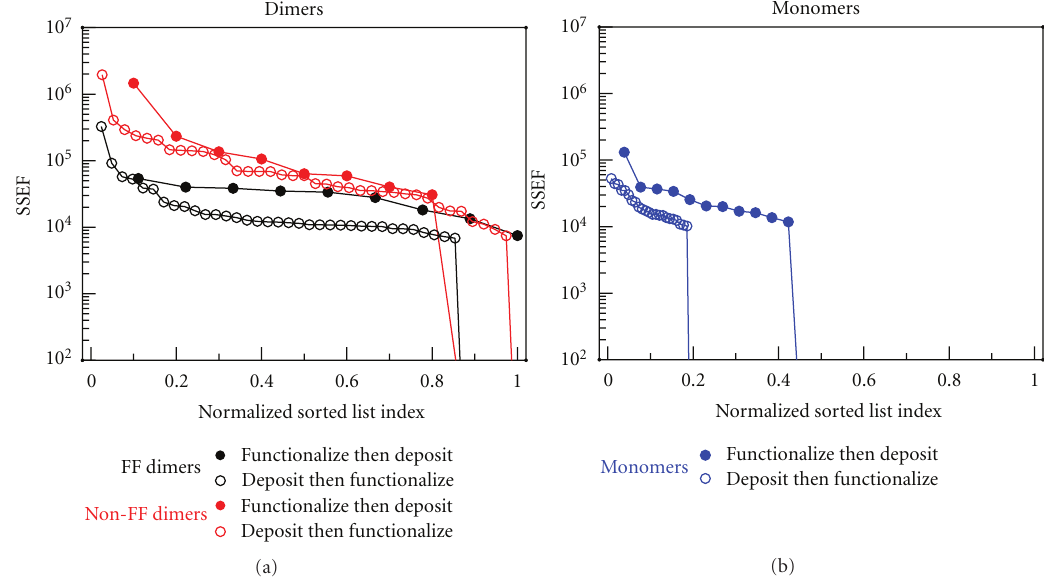
Figure 8: Pre- and post-deposition functionalization of silver nanocubes. Sorted SSEF data from (a) silver nanocube dimers and (b) silver nanocube monomers. The categories are FF dimer with no gaps (black), non-FF dimers with no gaps (red), and monomers (blue). Excitation wavelength: 633 nm. Nanocube size: